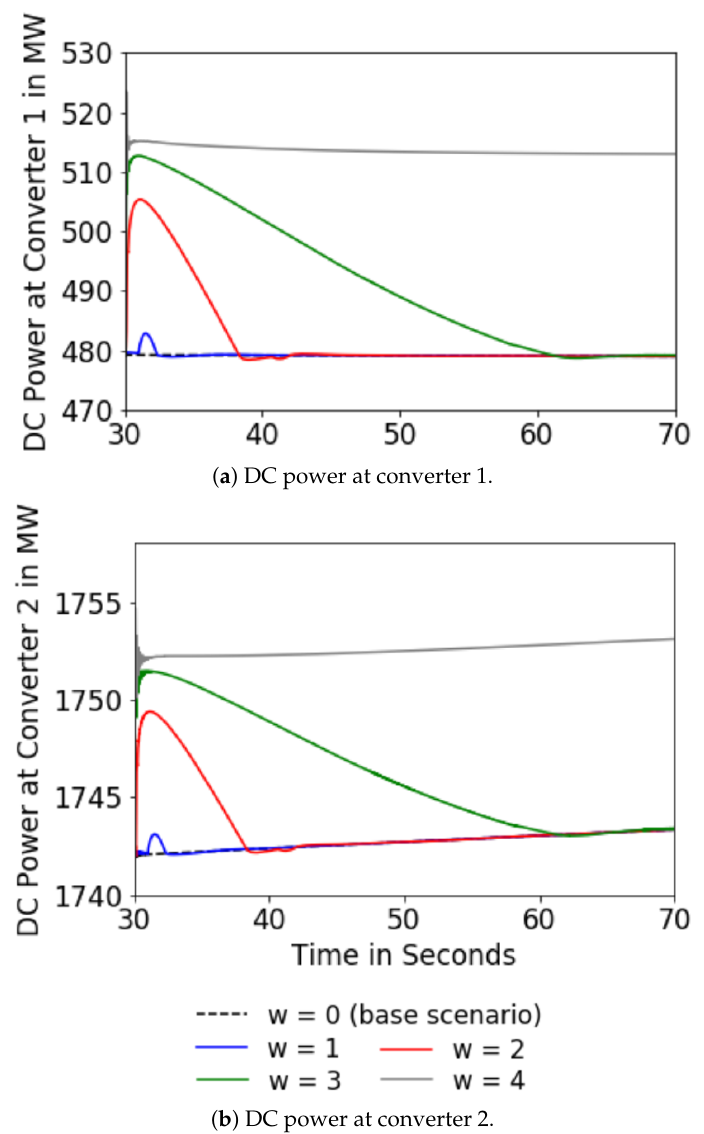
Figure 12. Active power response scenario